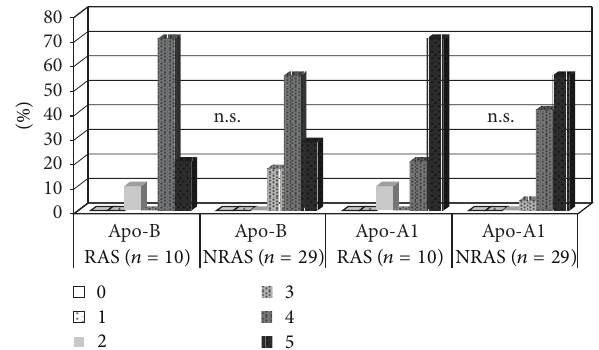
Figure 4: Degree of apolipoprotein B and A-1 deposition in RAS as compared to NRAS valves, data given as number of valves in percent (%) of ( 𝑛 ). RAS = rheumatic aortic stenosis, NRAS = nonrheumatic